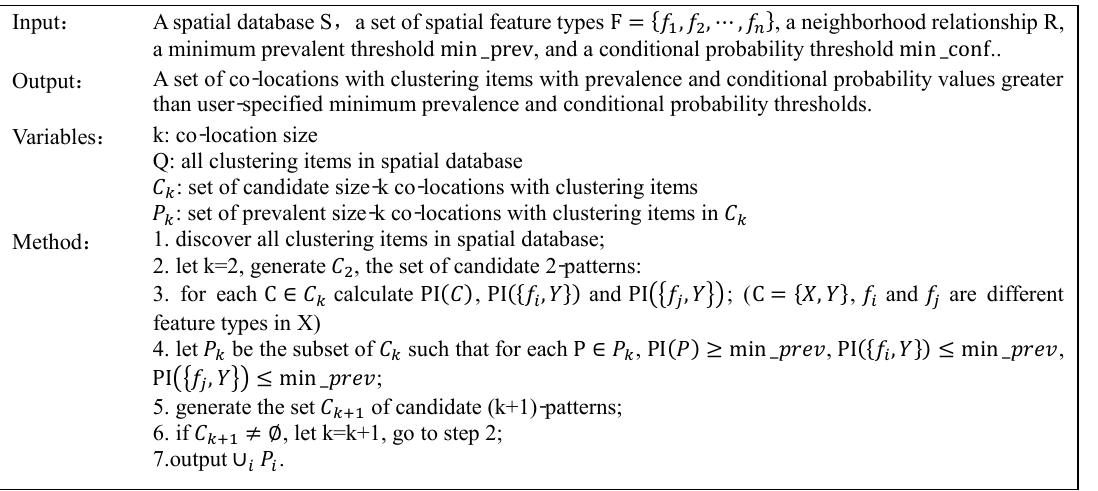
Figure 3. The algorithm for mining co-location patterns with clustering